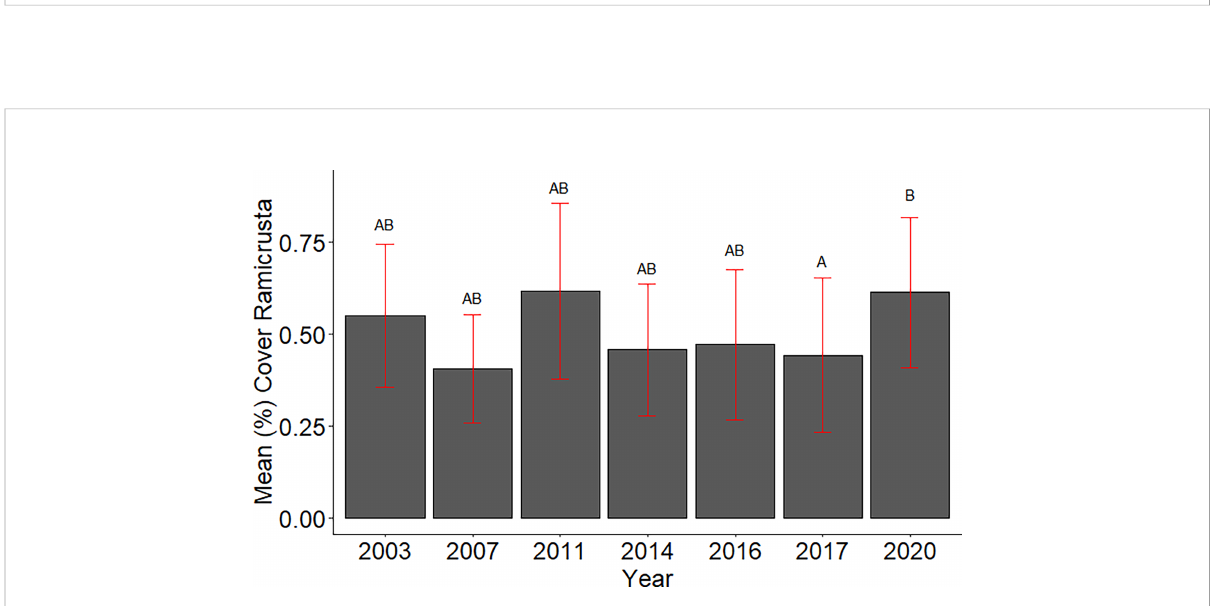
FIGURE 7 Mean percent cover of Ramicrusta in DAR-WHAP surveys 2003 - 2020. Bars represent standard error of the mean. The DAR-WHAP data indicate signi fi cantly higher abundance of Ramicrusta in 2020 than in 2017. Shared letters indicate annual means that are not signi fi cantly different based on a Tukey post-hoc comparison test.